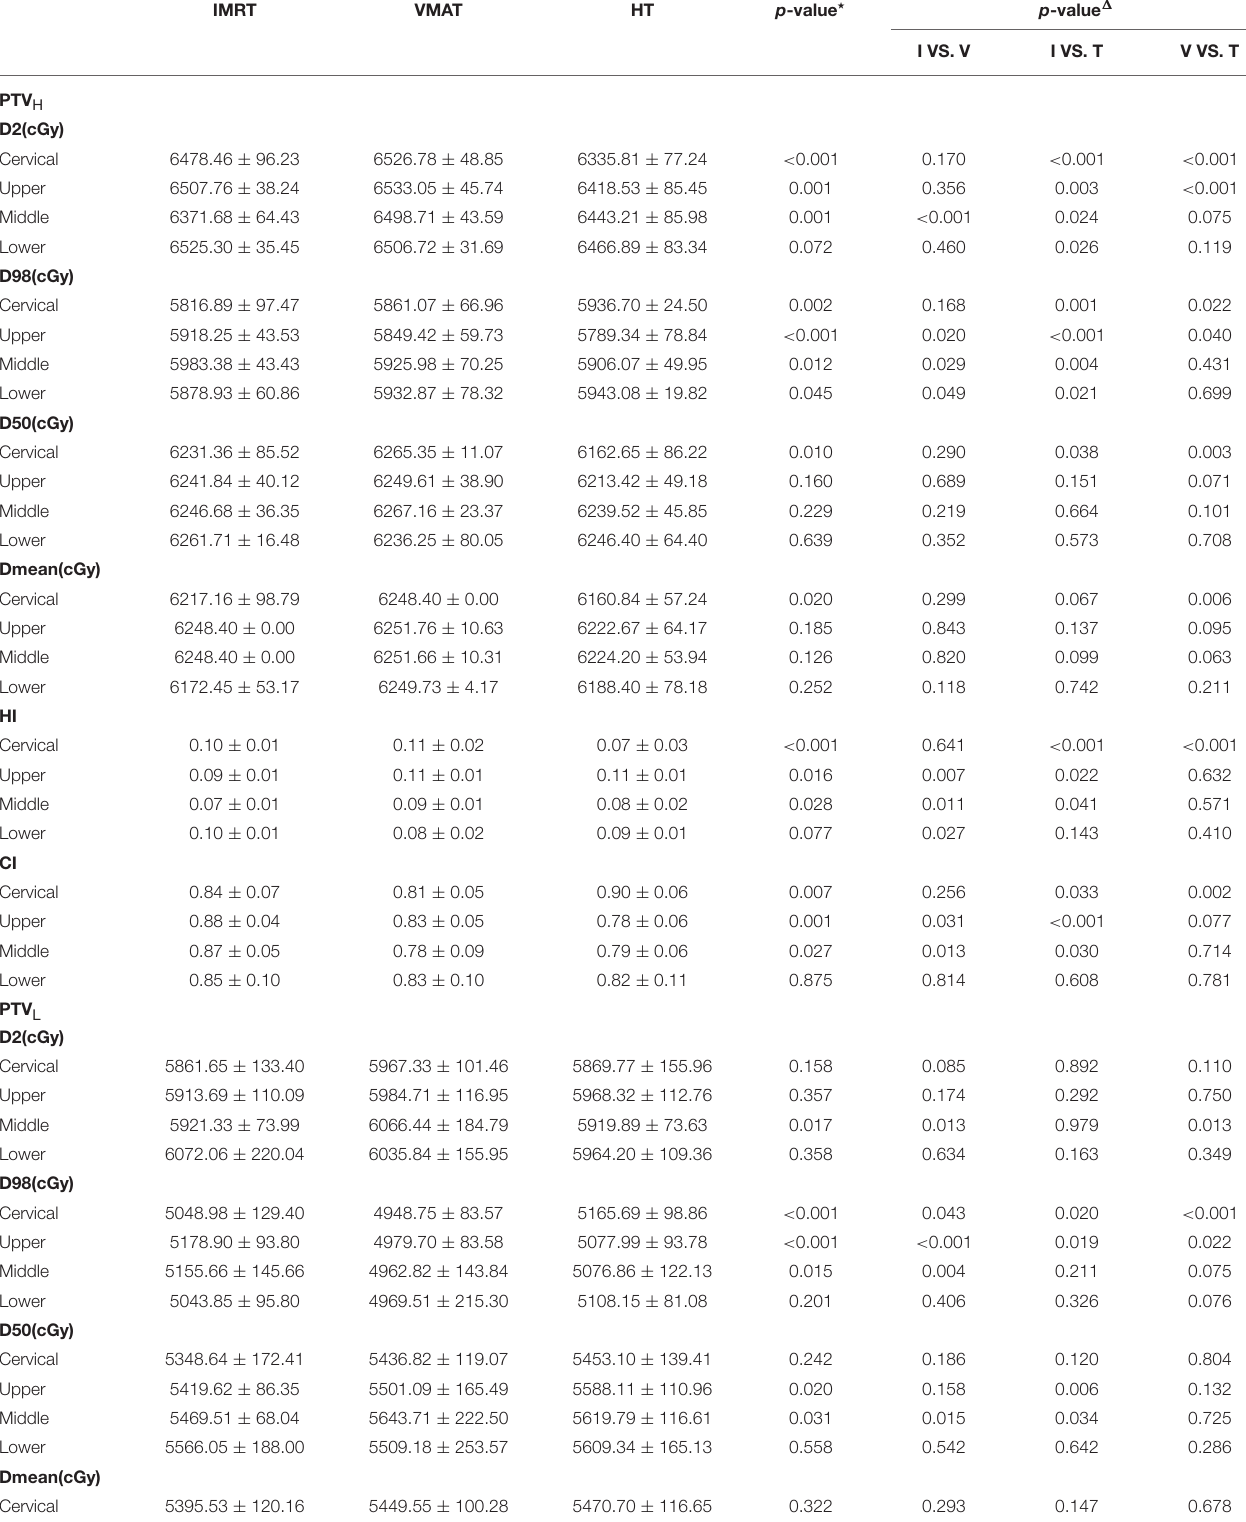
TABLE 3 | Dosimetric results for PTVs in cervical, upper, middle, and lower thoracic EC. IMRT VMAT HT p -value ⋆ p -value 1